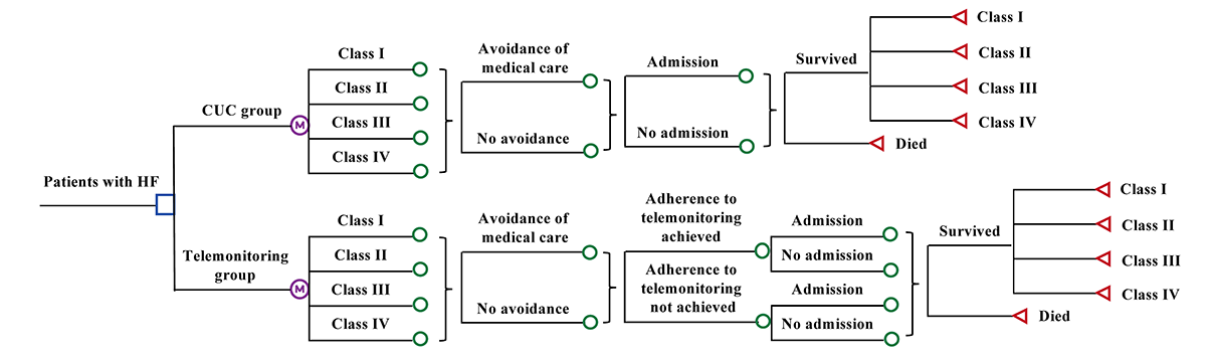
Figure 1. Simplified Markov model of telemonitoring for patients with HF. CUC: care under COVID-19; HF: heart